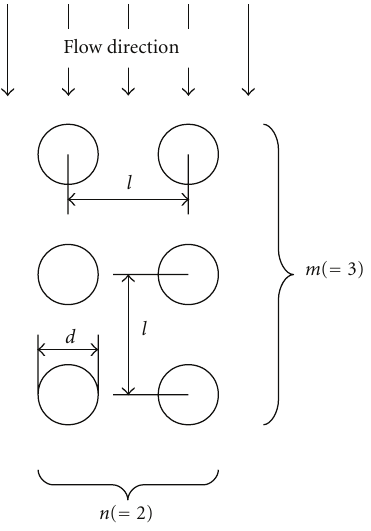
Figure 3: Plan view of the pile group and riprap